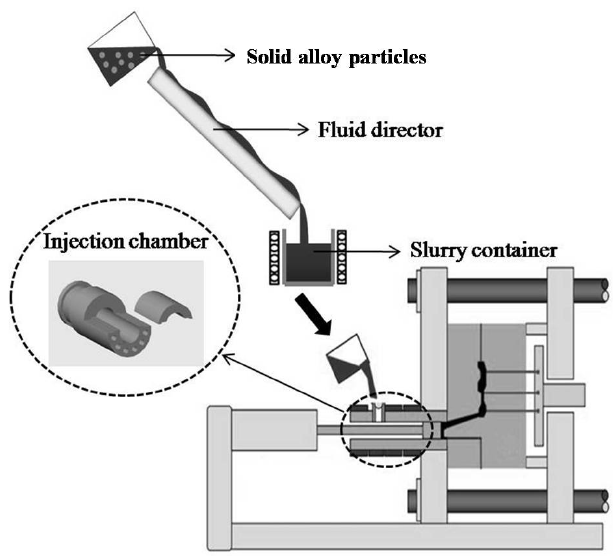
Figure 4. Schematic diagram of SIRD process.